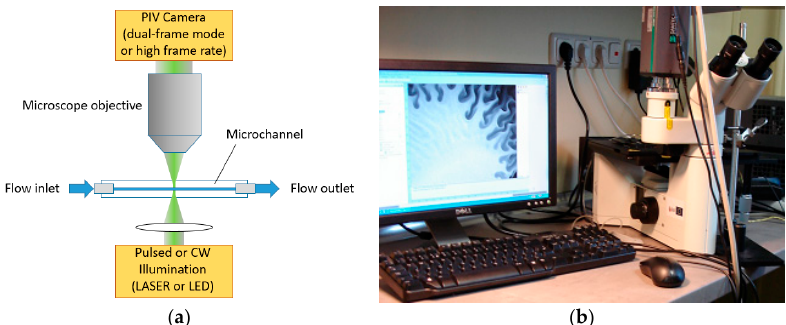
Figure 2. ( a ) 2D2CµPIV measurement in shadow illumination mode. ( b ) A 2D2CµPIV system featuring an inverted fluorescence microscope and a single PIV camera.